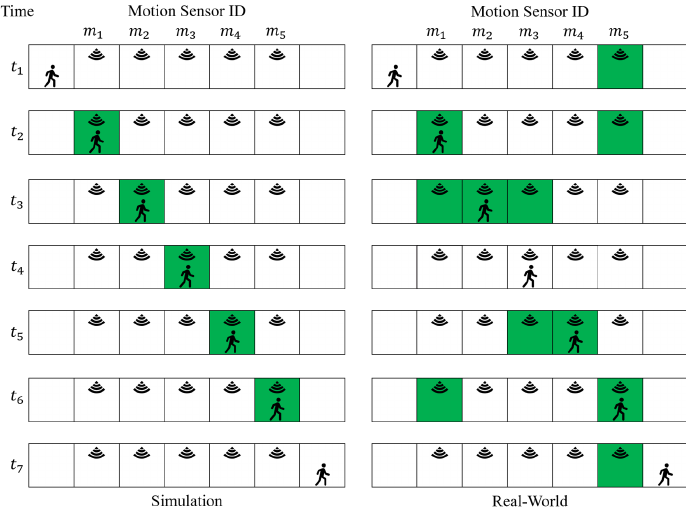
Figure 3. A simple environment as an example for our methodology. The green color shows which motion sensor gets activated in each